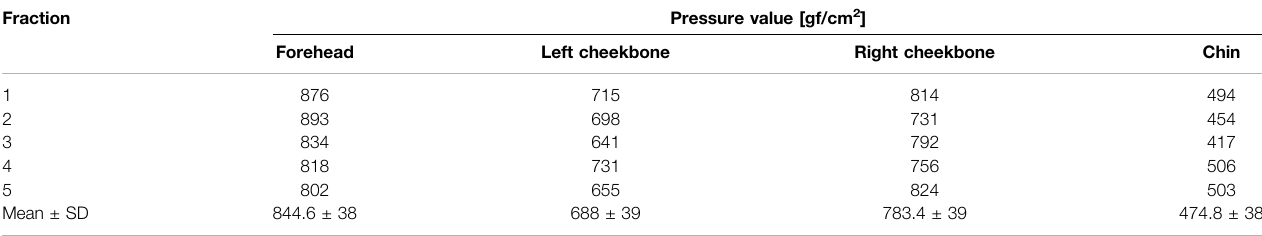
TABLE 2 | Result summary of the thermoplastic mask setup reproducibility test with a rigid head phantom. In each trial, the data were acquired at every 100 ms for 3 min, and the data represent the mean values of 1,800 samples for each fraction.